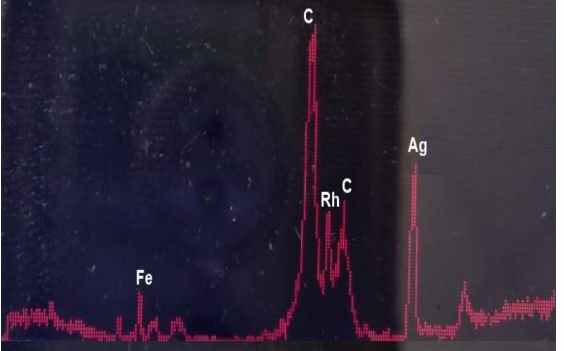
Figure 2. EDXRF spectrum of poly(HDDA)/graphene microspheres (C—Compton peaks; Rh— K α + K β